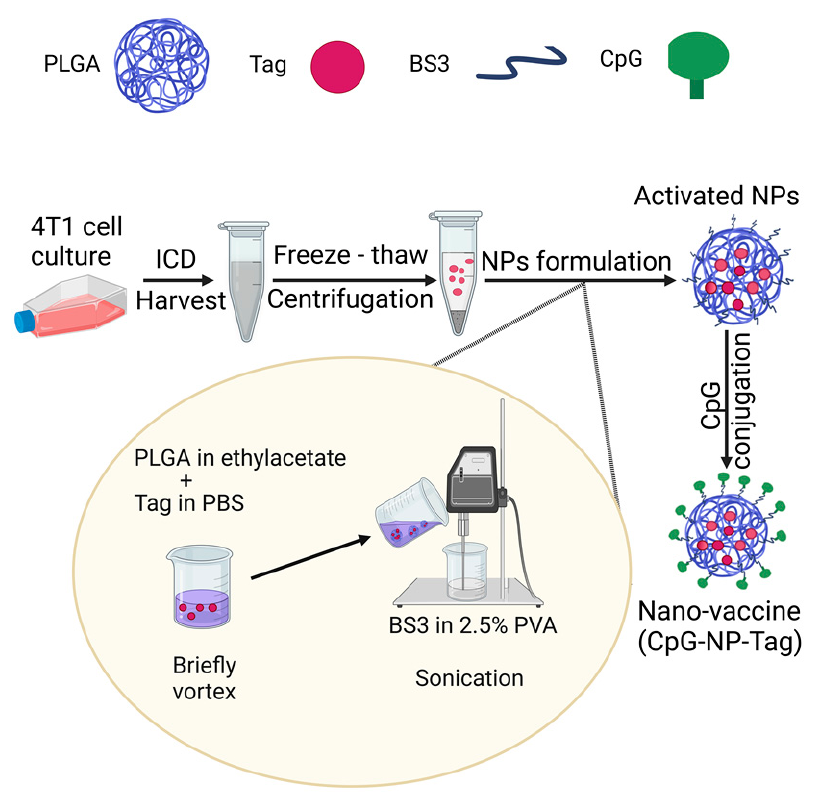
Figure 1. Formulation of nasal nano-vaccine (Intranasal CpG-NP-Tag). Diagram summarizing the